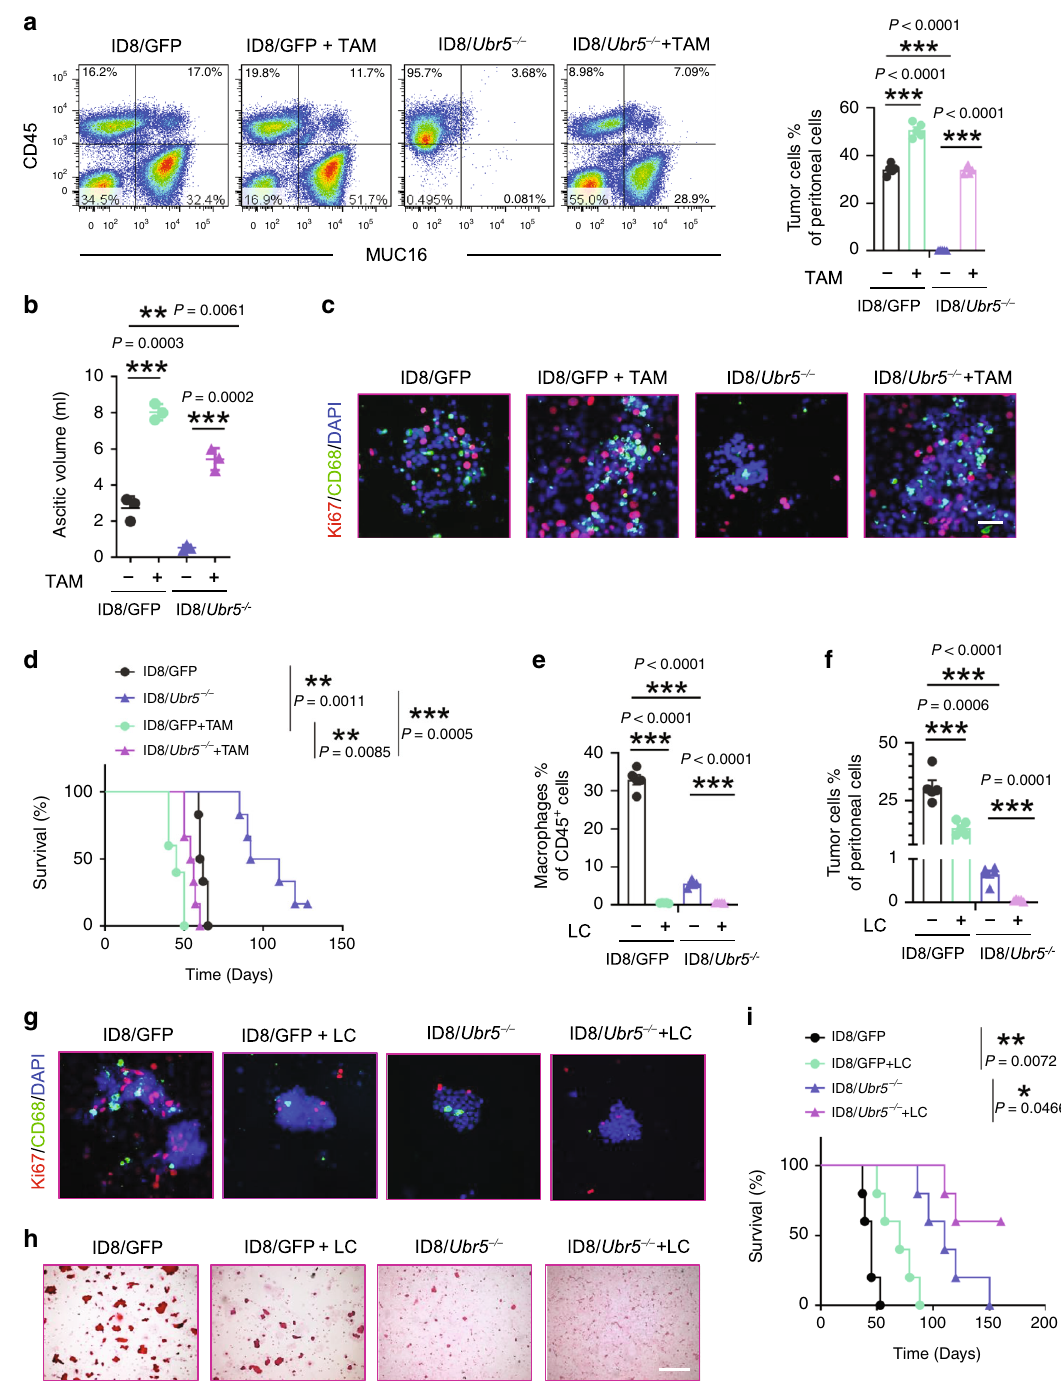
Fig. 3 Impaired macrophage recruitment and attenuated peritoneal growth of UBR5-de fi cient OC. a Representative FACS images and proportion of Muc16 + CD45 − tumor cells ( n = 5 mice per group). b Ascitic fl uid volumes were measured at day 40 ( n = 5 mice per group). c Representative images of CD68 + macrophages and surrounded Ki67 + cells. All panels are the same magni fi cation, scale bars: 50 μ m. d Survival in ID8 bearing mice with or without exogenous TAMs ( n = 6 mice per group), log-rank test. e , f Proportion of in fi ltrated CD11b + F4/80 + macrophages ( e ) and Muc16 + CD45 − tumor cells ( f ) ( n = 5 mice per group). g Representative images of CD68 + macrophages and surrounded Ki67 + cells ( n = 3 mice per group and ten confocal images acquired from each sample). All panels are the same magni fi cation, scale bars: 50 μ m. h Spheroids from peritoneal washes (same volume) were harvested and evaluated by H&E staining ( n = 3 mice per group and an average of ten fi elds acquired from each sample). Scale bars: 200 μ m. i Survival in ID8 bearing mice with or without LC treatment ( n = 5 mice per group), log-rank test. All data are representative of two independent experiments with similar results. Data are presented as mean ± SEM, unpaired two-sided Student ’ s t -test with no correction for multiple comparison,* P < 0.05, ** P < 0.01, *** P < 0.001. Source data are provided as a Source Data fi